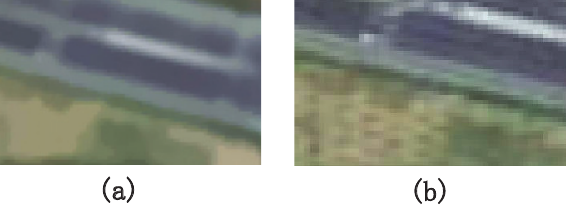
Figure 3. (a)Local meanshift filter result (b)Local origin image Overall result is shown in Figure